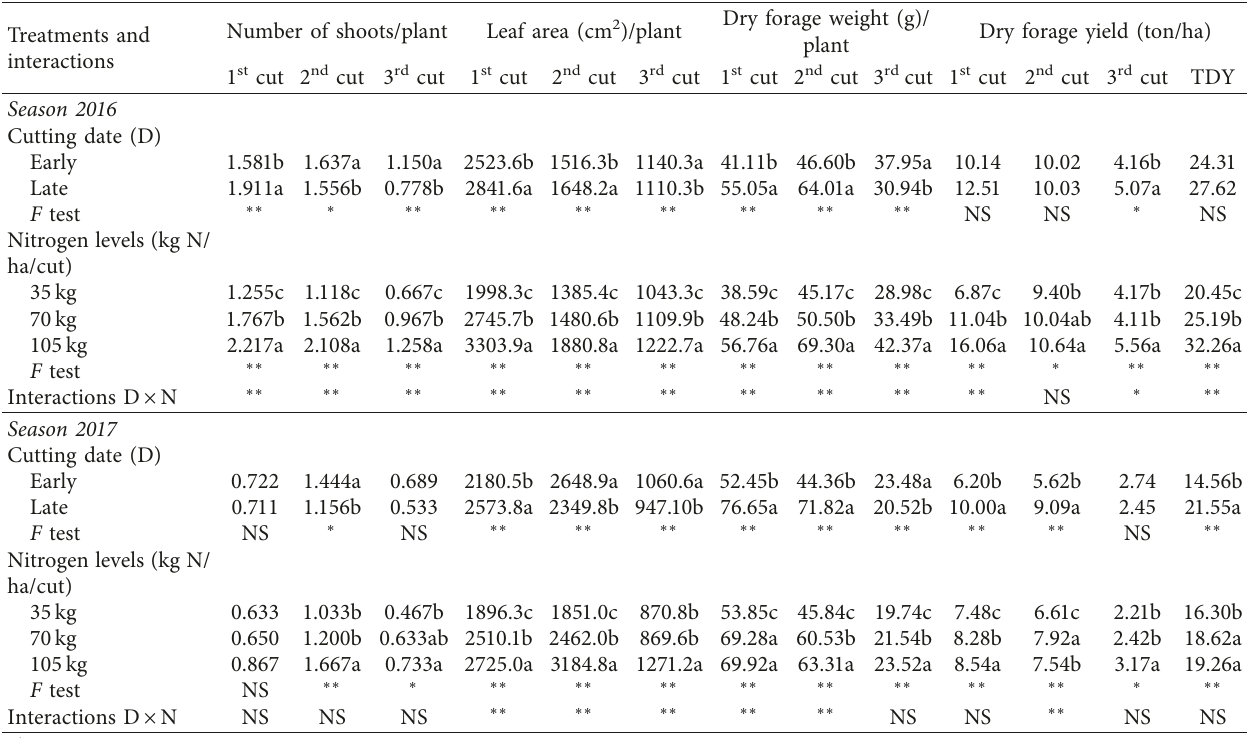
Table 3: Effect of the cutting date and nitrogen fertilizer on the number of shoots per plant, leaf area, dry forage weight per plant, and dry forage yield of Sudan grass (tons/ha) during 2016 and 2017 summer seasons.